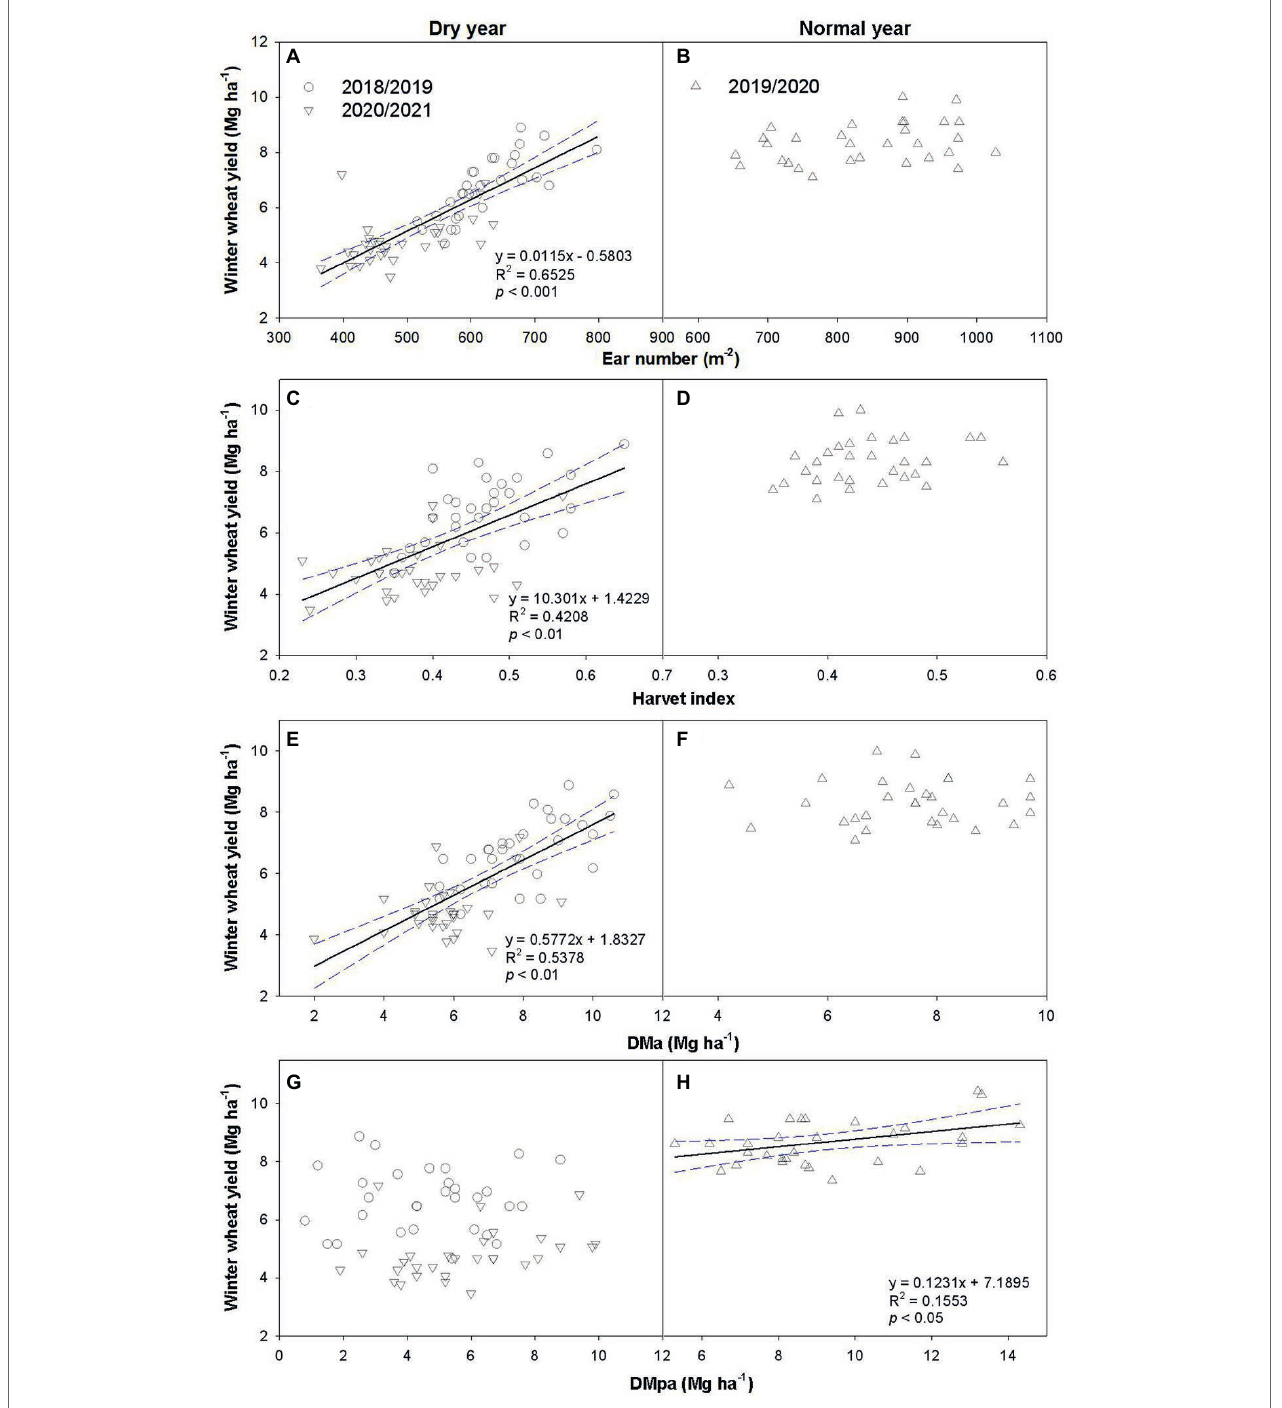
FIGURE 5 | Relationships between wheat yield and ear number (A,B) , harvest index (C,D) , dry matter accumulation at anthesis (DMa; E , F ), and dry matter accumulation during post-anthesis (DMpa; G , H ) in dry and normal years,